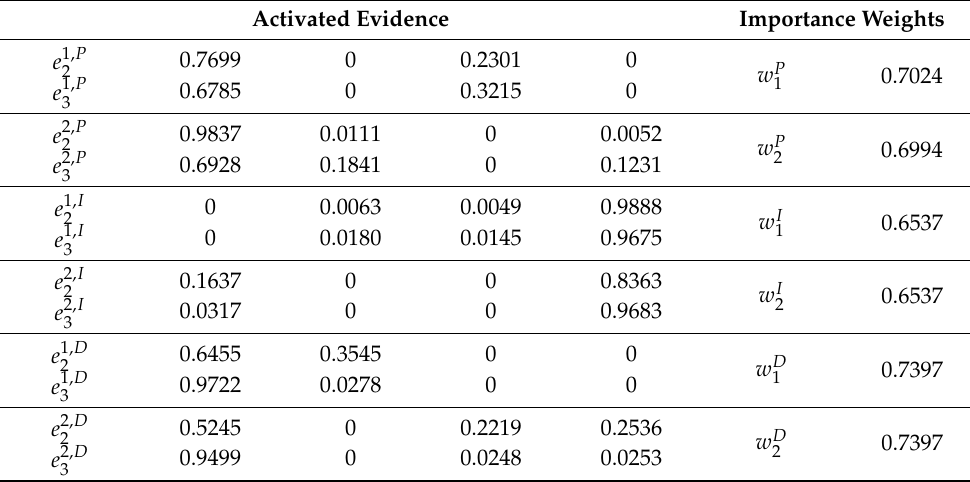
Table 12. Evidence activated at time k = 4 and their corresponding importance